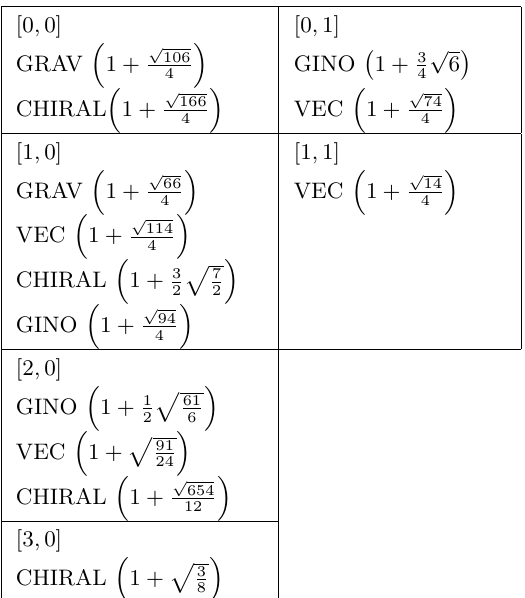
Table 3 . Supermultiplets at KK level n = 1 for the D = 11 N = 1 G 2 -invariant AdS 4